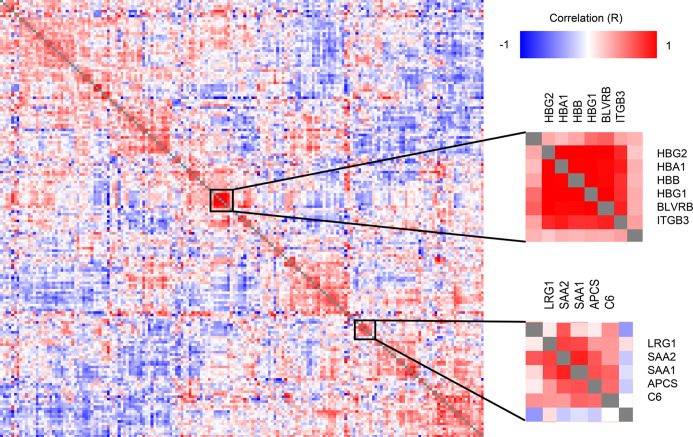
Clustered Pearson’s protein-protein correlation matrix of protein changes during the first week of life, of all quantifiable proteins (on the x- and y-axis) which allows for identifying proteins with similar trajectories across all samples. Several clusters of correlating proteins were identified, including a cluster centered around hemoglobin and an acute phase response cluster including SAA1 and SAA2.